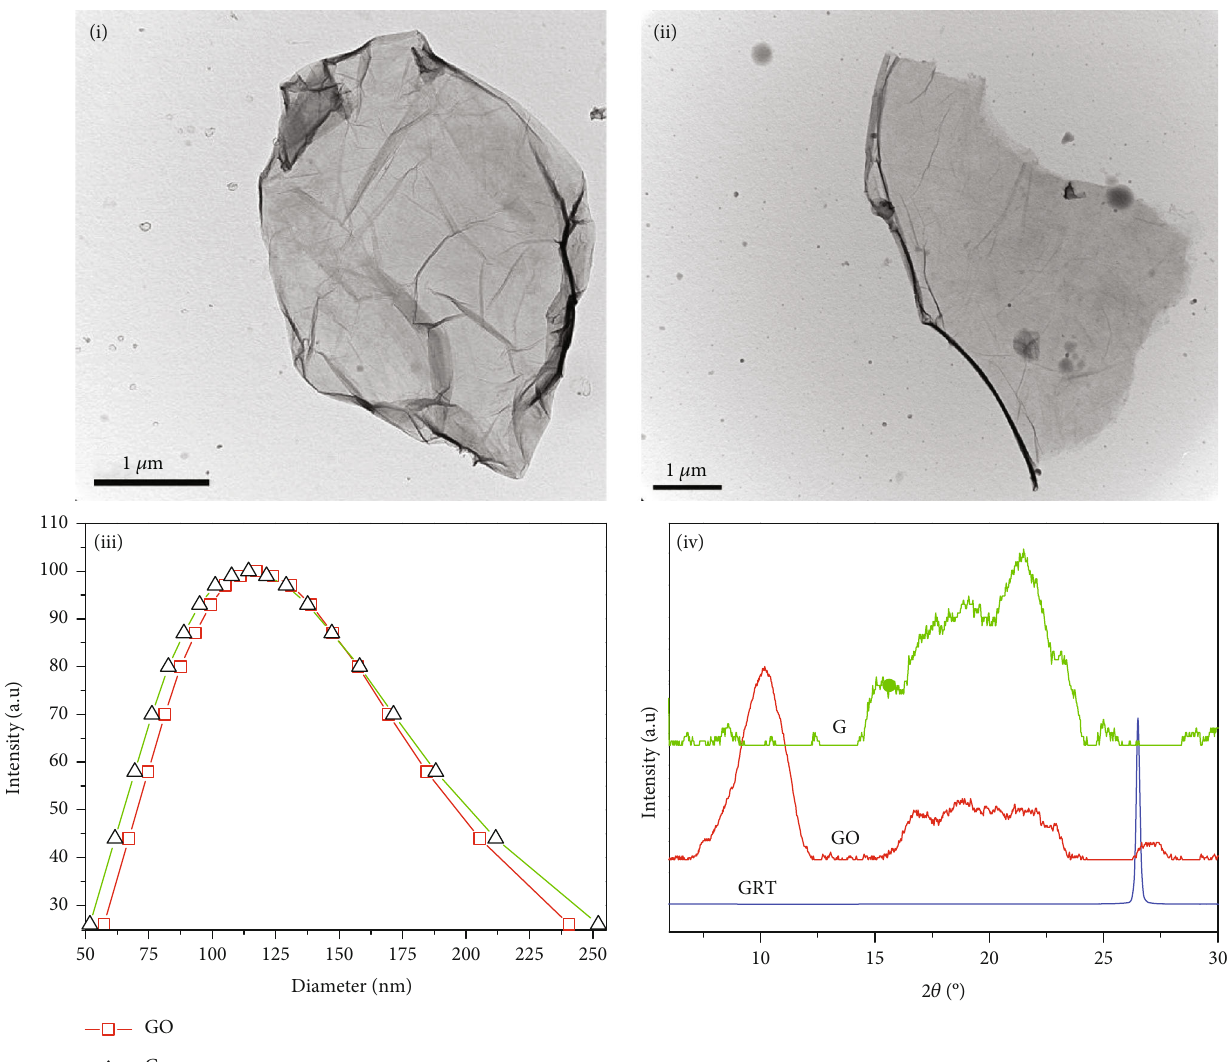
Figure 2: Characteristics of GO and GO sheets; (i) TEM image of GO-sheets, (ii) TEM image of G-sheets, (iii) dynamic light scattering (DLS) of GO and G-sheets, and (iv) wide angle X-ray di ff raction analyses of GO, G, and